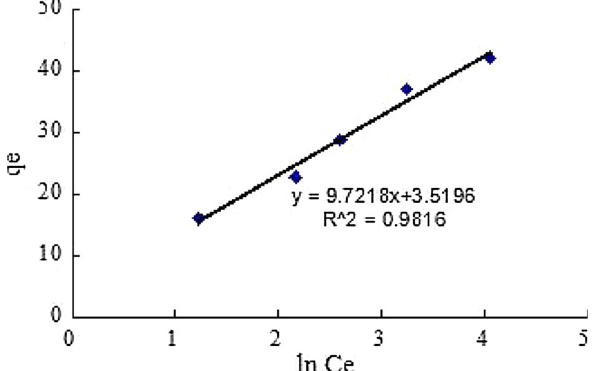
Fig. 9 Temkin isotherm showing the variation of q e against ln C e for adsorption of As(III) onto